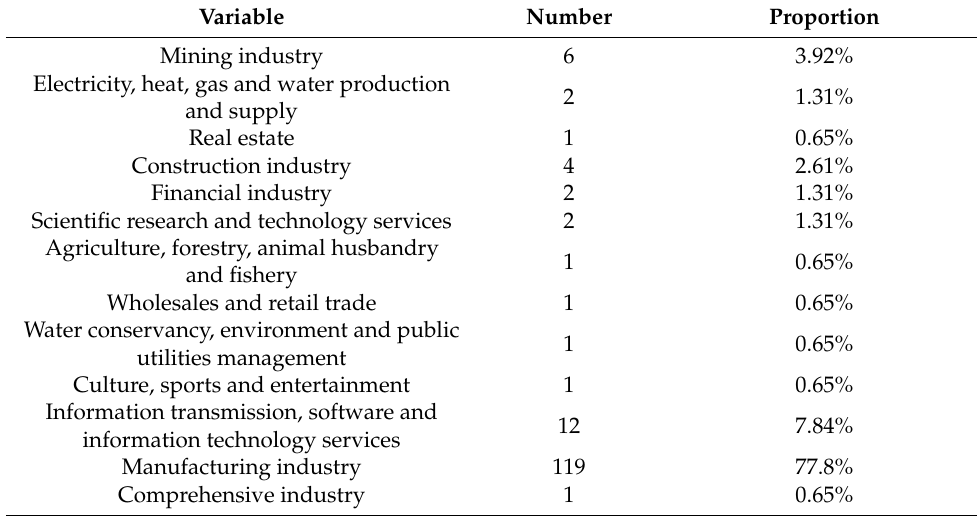
Table 2. The number of companies and their industry distribution.